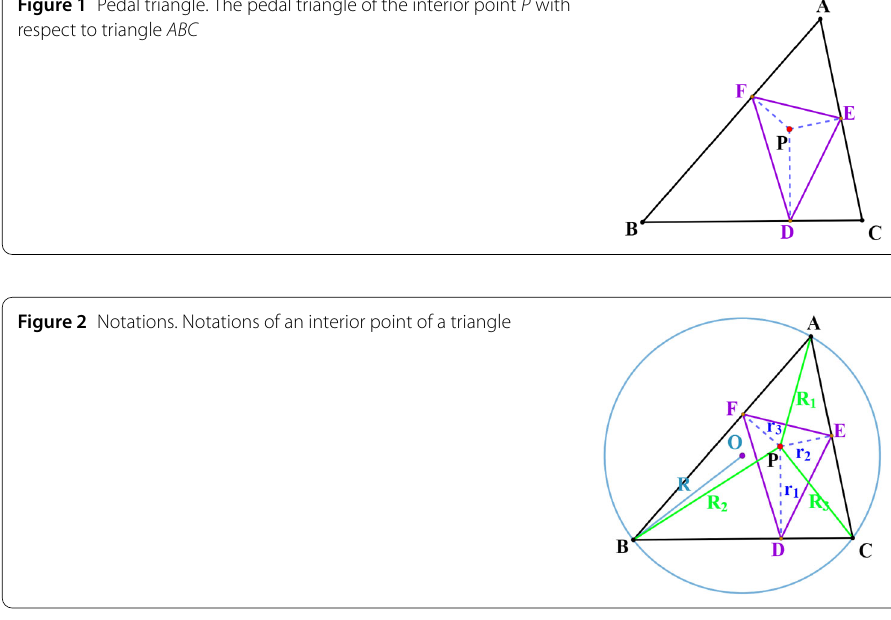
Figure 1 Pedal triangle. The pedal triangle of the interior point P with respect to triangle ABC